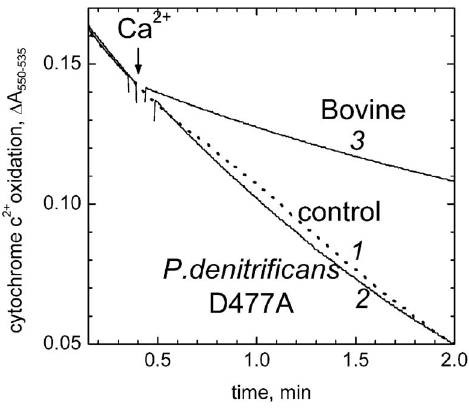
Figure 6. Ca 2 + does not inhibit cytochrome c 2 + oxidase activity of D477A mutant COX from P.denitrificans . D477A mutant COX (1.5 nM) in the basic medium with 0.4 M choline chloride. Oxidation of 10 m M reduced cytochrome c is followed spectrophotometrically in a dual-wavelength mode at 550 nm vs the 535 nm reference. Trace 1 (dotted line), control recording with no calcium added; trace 2 , 200 m M CaCl 2 added where indicated. Trace 3 , the same conditions as in trace 2 but with 2.5 nM bovine heart COX.